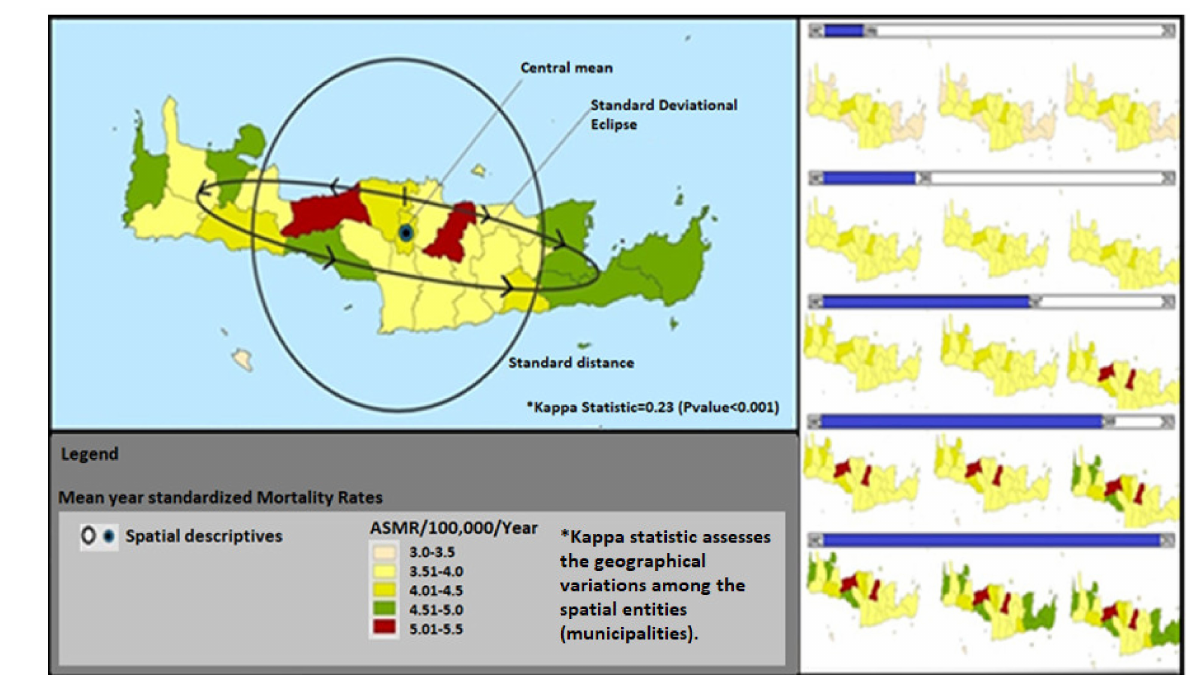
Figure 3. Geographical distribution and temporal trends of colorectal Age-Standardized Mortality Rates/100,000/year in Crete, (Source: Cancer Registry of Crete).